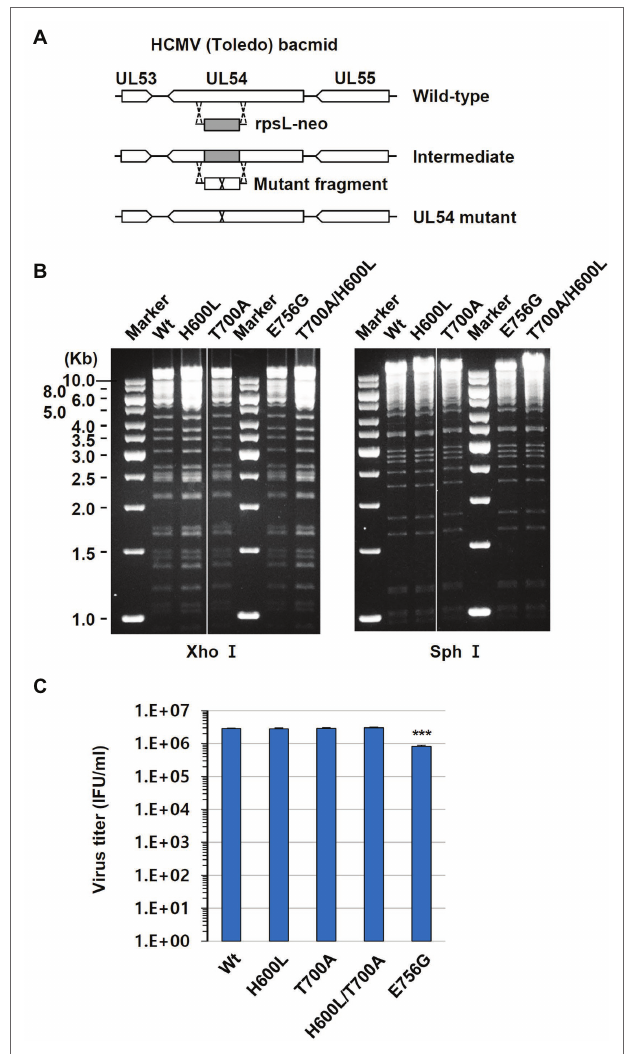
FIGURE 1 | Production of human cytomegalovirus (HCMV) bacmids containing UL54 mutations. (A) Strategy for the production of HCMV bacmids containing UL54 mutations using a counter-selection BAC modification kit (see Materials and Methods). (B) Wild type and UL54 mutant bacmids were digested with Xho I or Sph I and subjected to agarose gel electrophoresis. (C) HF cells (1.5 × 10 5 cell per well) in 12-well plates were infected with recombinant viruses containing the wild type or mutant UL54 gene at an MOI of 1 (IFU/ml) for 5 days. Progeny virus titers in the culture supernatants were measured by infectious center assays. Results shown are mean values and standard errors of triplicates. Statistical significance between the wide type and each mutant virus was determined using Student’s t -test. The values of p < .05 are considered statistically significant and the value of p < .001 (***) is